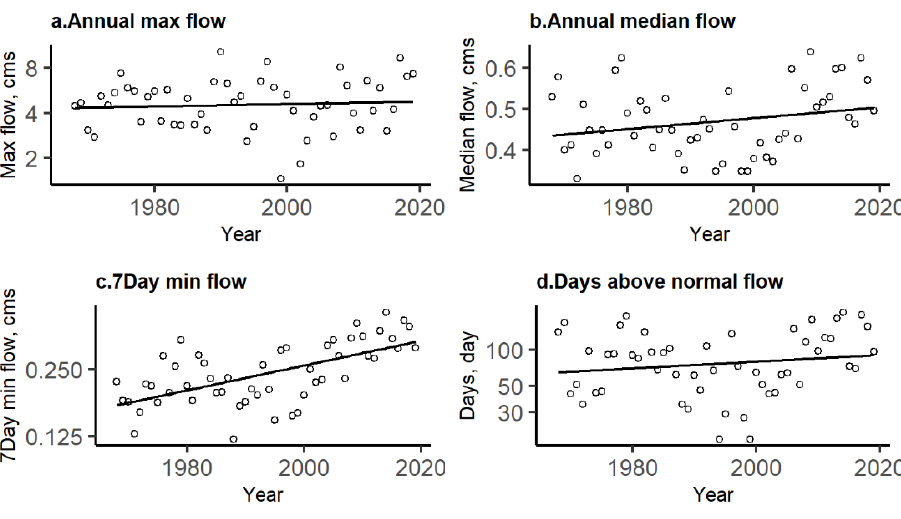
Figure 4. Streamflow regime of the Orangeville (rural) gauge located in the main channel. ( a ) Annual max flow, ( b ) Annual median flow, ( c ) 7-day min flow, ( d ) Days above normal flow.